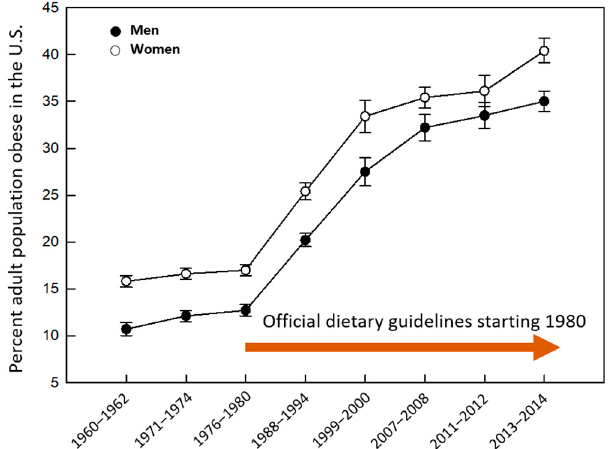
Figure 1. Age-adjusted prevalence of obesity by sex in the United States, 1960–2014. Data for ages 20–74. Overweight population and pregnant females were excluded. Graph generated using publicly available data from the National Center for Health Statistics, the National Health Examination Survey, and the National Health and Nutrition Examination Survey.